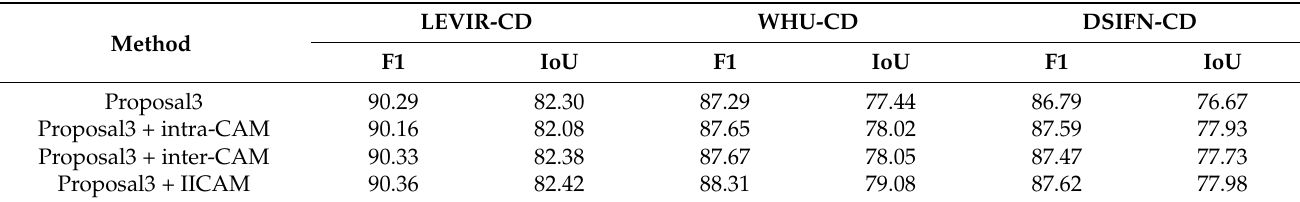
Figure 8. The diagram of the four stages of the feature map and their integration. xi denotes the four-stage feature map, pre indicates fusion that utilizes IICAM previously, and post denotes fusion that utilizes IICAM post. Red represents the semantics of the object; blue represents irrelevant objects and fills in the boundaries of the object. Table 2. Ablation studies of IICAM on three test